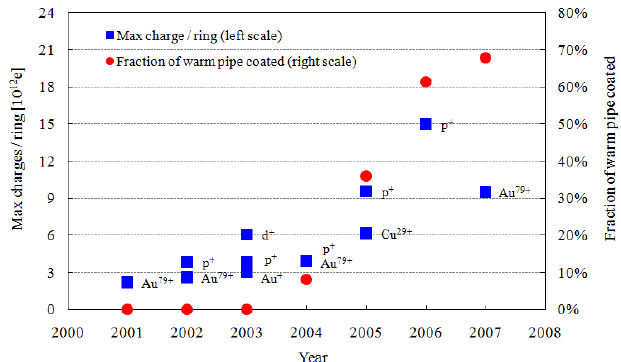
FIG. 15. (Color) Total charge of RHIC beams versus fraction of warm beam pipes coated with NEG. Large-scale application of NEG pipes began in 2005. Note that the intensity of gold beams is also constrained by the injectors and intrabeam scattering, and the intensity of polarized protons by the beam-beam interaction.